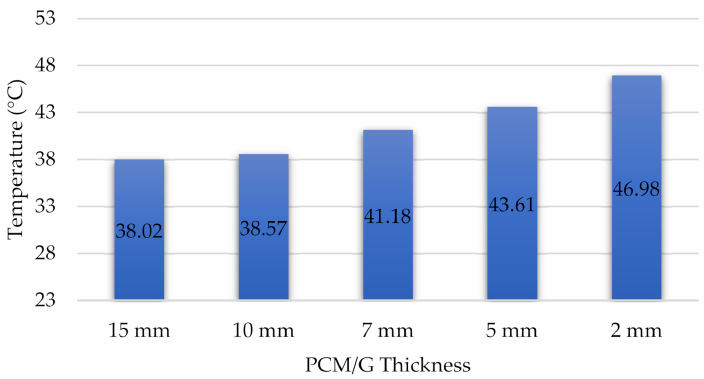
Figure 7. Comparison of the temperature evolution for three different scenarios, including natural convection (NC), PCM cooling, and PCM/Graphite cooling under 150 A current